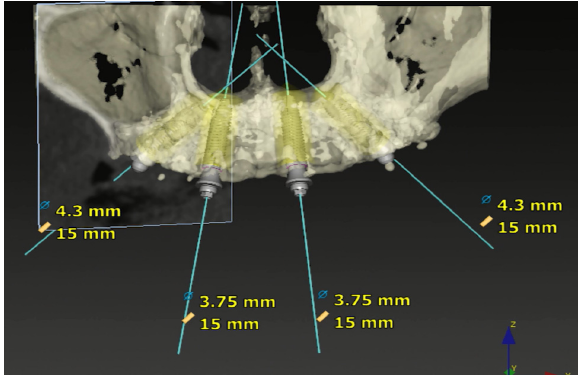
Figure 5. Perioperative intraoral photograph after the TriStar screws insertion.